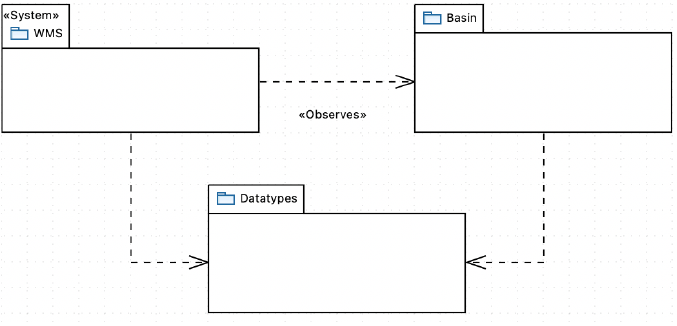
Figure 12. Water Alert System overview.